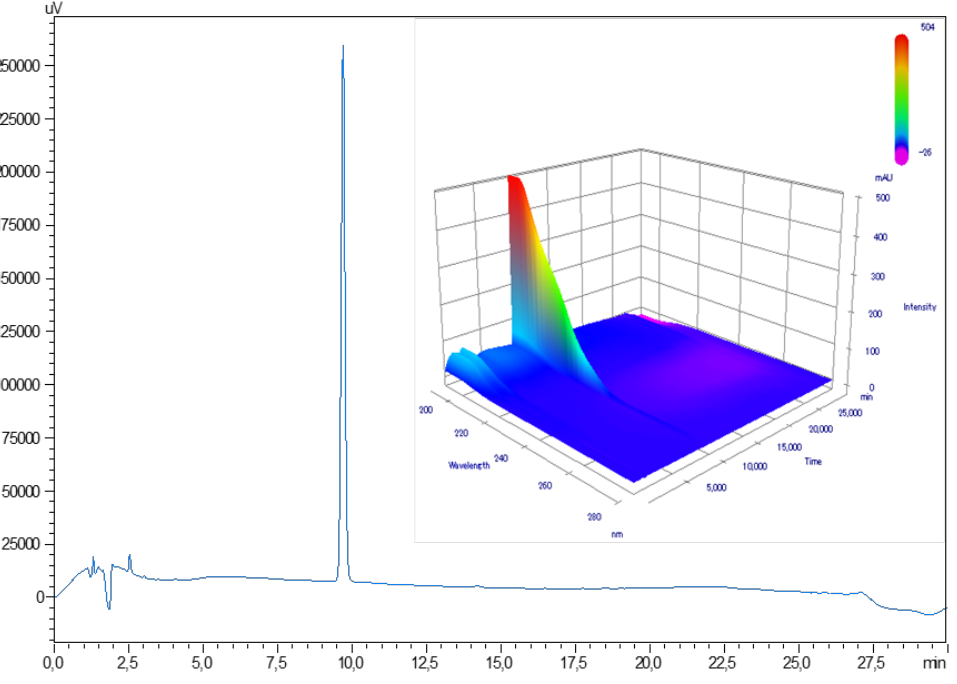
Figure 1. Reference chromatogram of a 0.1 mg/mL atropine solution at 210 nm and with diode array detector screening.